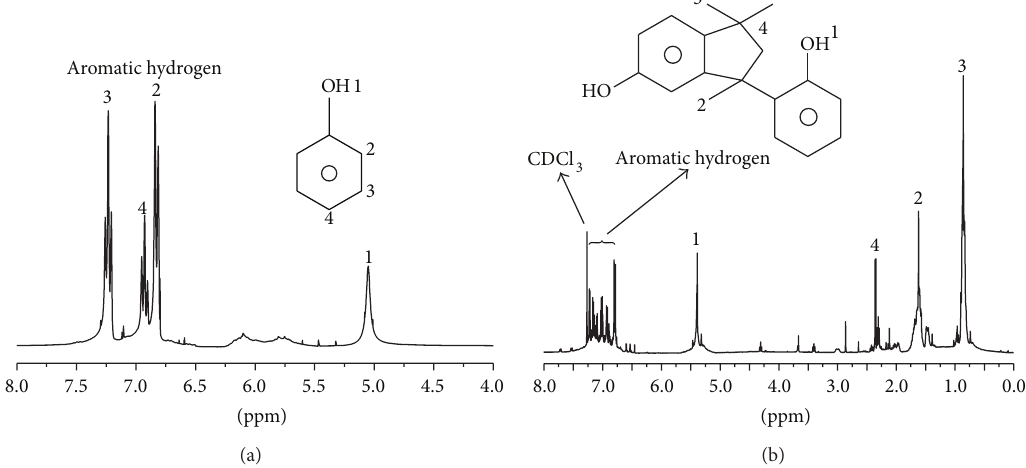
Figure 6: Proton nuclear magnetic resonance spectrum acquired from the two main components of the residues.